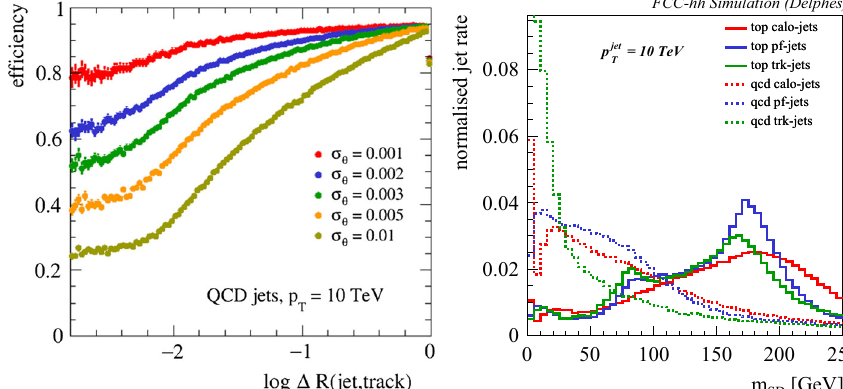
reconstruction efficiency inside highly boosted QCD jets as function of the angular distance (cid:14) R between the track and the center of the jet for different assumptions on the tracker spatial resolution. Right: reconstructed “soft-dropped” jet mass of highly boosted top and QCD jets with various sets of input to the jet clustering algorithm: tracks only, calorimeters towers only and particle-flow